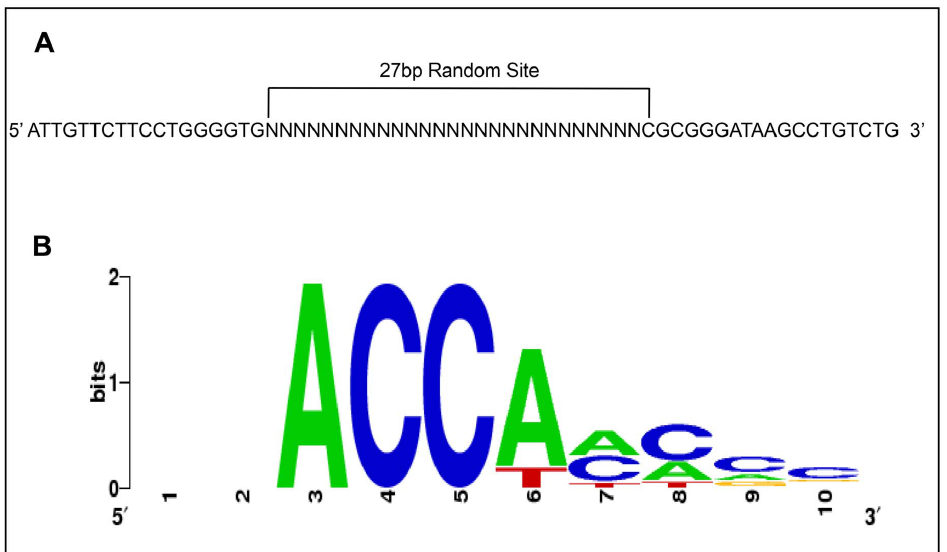
Figure 1. Cylic amplification and selection of targets (CASTing) recovered a suite of hexamer target sequences that bound to AtMYB61. (A) 27 bp random sequences flanked by two primer sites (63 bp in total) were used in the CASTing assay. (B) Sequence logo of CASTing targets discovered by MEME. The ACC motif was conserved among all target sequences. Two nucleotides upstream and downstream of the over- represented hexamer target sequences were included to analyse if the over-represented motifs could be extended beyond a hexameric sequence.